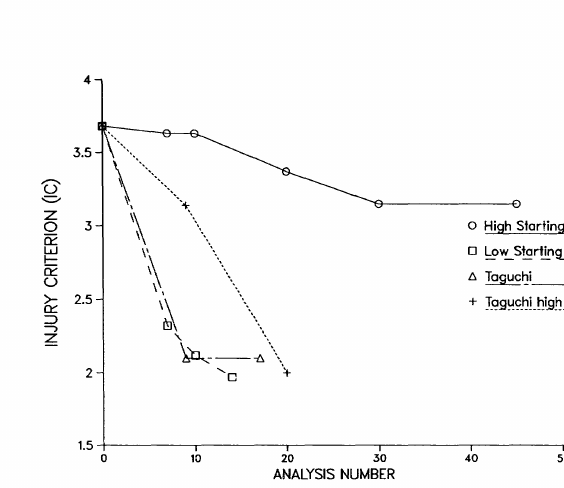
FIGURE 5 Optimization histories for second-order solutions to example 2.